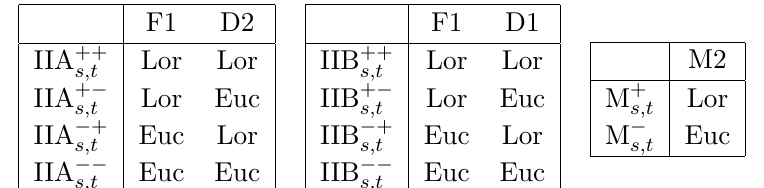
Table 1 . Notation for exotic string theories and M-theories, where ( s; t ) denotes the spacetime signature. The superscript signs + and (cid:0) denote whether certain branes are Lorentzian (Lor) or Euclidean (Euc), respectively. For spacetime signatures other than ( D (cid:0) 1 ; 1), \Euclidean" (\Lorentzian") indicates an even (odd) number of worldvolume times. IIA ++ denote the usual string and